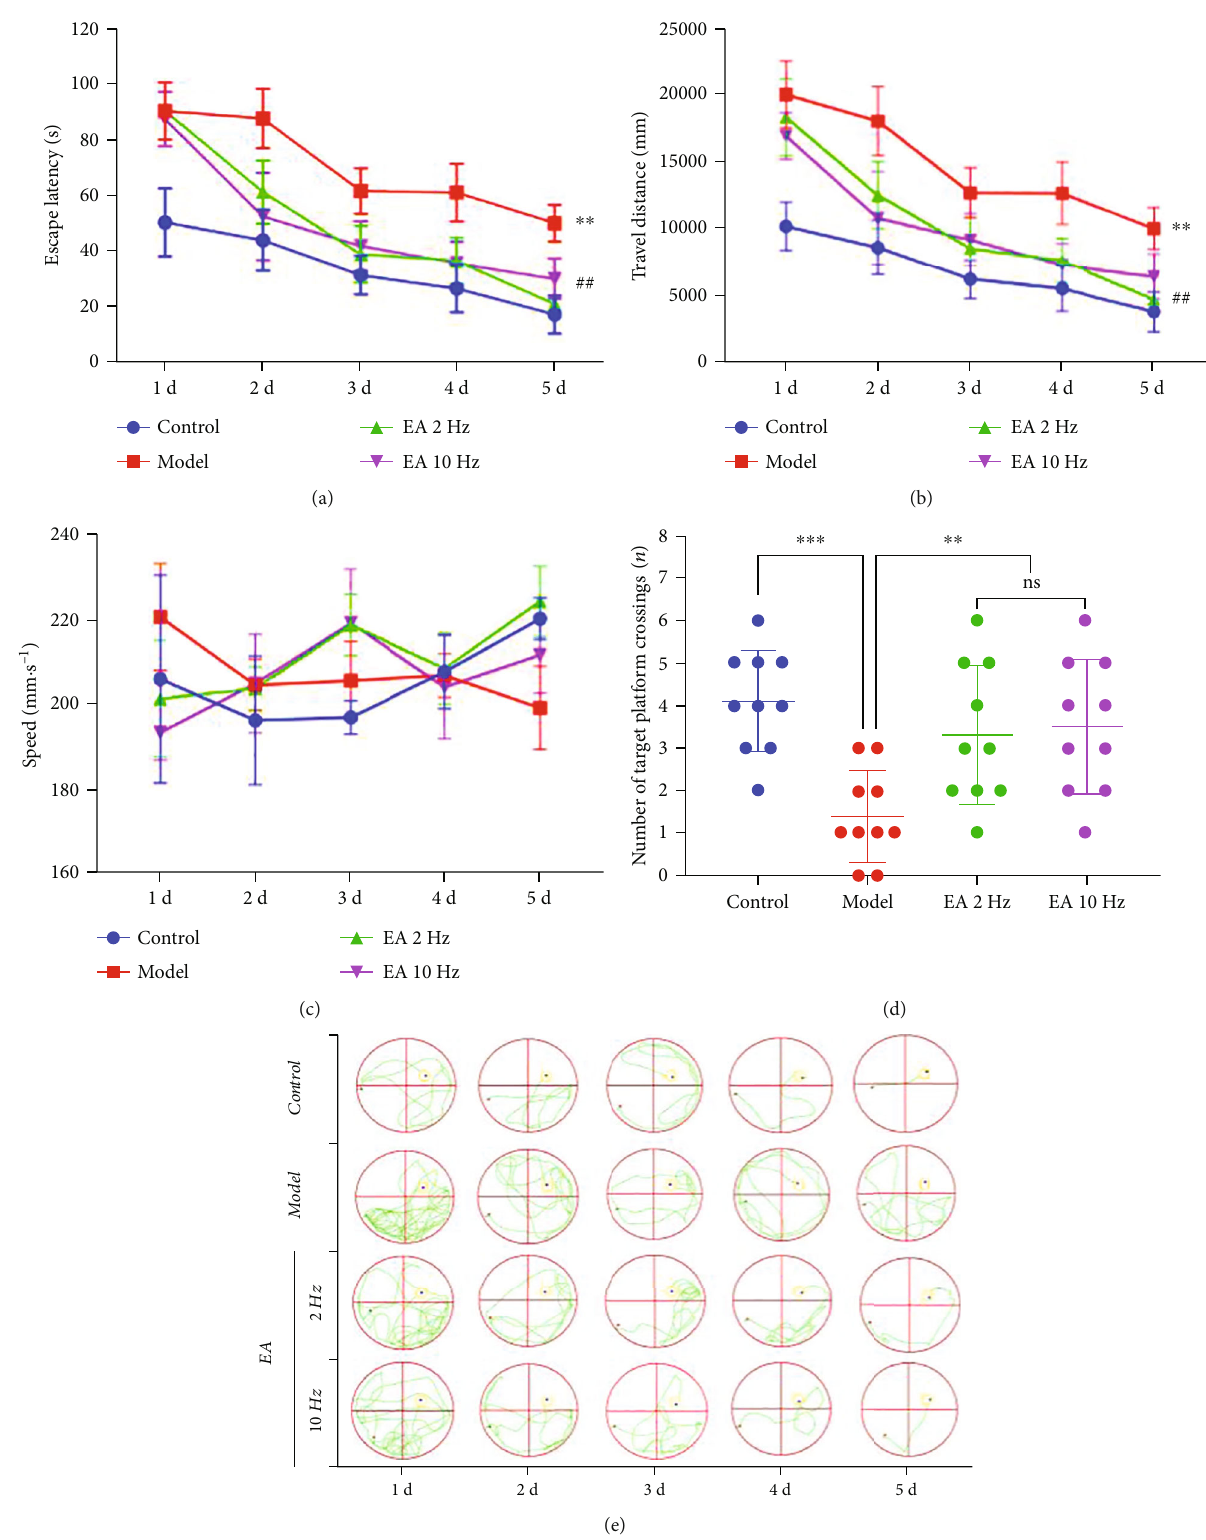
Figure 2: Electroacupuncture (EA) treatment enhanced learning and memory abilities in SAMP8 mice in two di ff erent cognitive function assessment experiments. (a) The escape latency in the navigation experiment. (b) The distance travelled in the navigation experiment. (c) The speed in the navigation experiment. (d) The target platform crossing number in the space exploration experiment. (e) The typical swimming trajectories in the navigation experiment. The data are shown as the mean ± SD of 10 mice per group. ∗∗∗ P < 0 : 001 and ∗∗ P < 0 : 01 vs. the model group; ## P < 0 : 01 vs. the 2 Hz EA group. ns: not signi fi